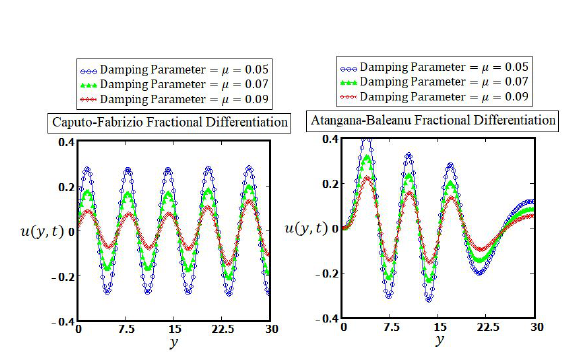
Figure 2: Graph of displacement via CF and AB fractional operator with three different variants of damping parameter µ